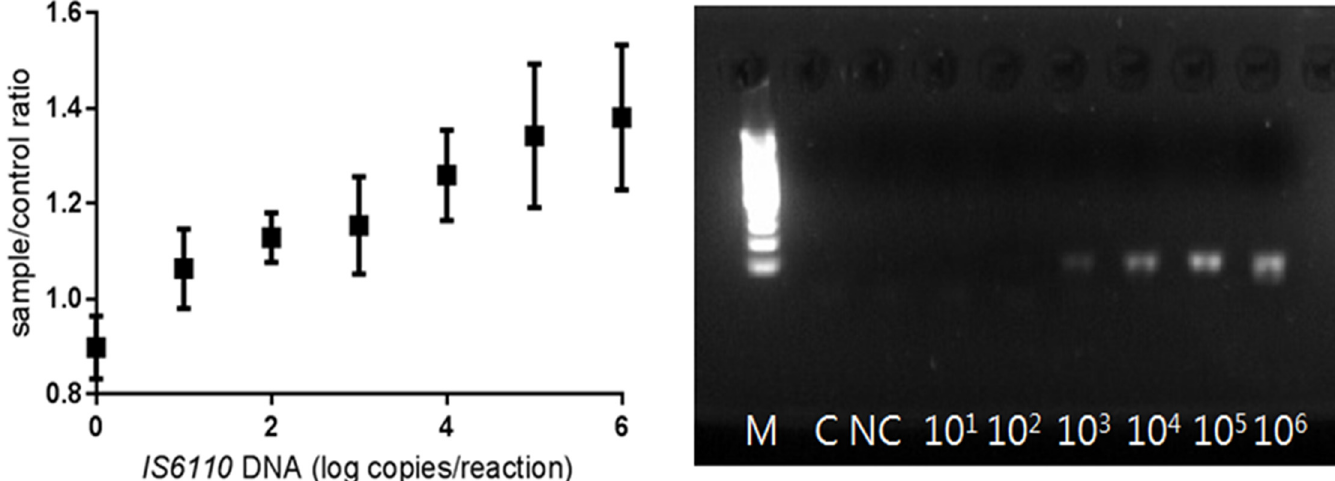
Fig 3. Detection sensitivity of the PCR-GO system. Left, The RFU ratios (sample/control) increased in proportion to the concentration of p-IS 6110 used for PCR amplification (10 1 – 10 6 copies/reaction). Negative group (no template control) was significantly different from positive groups (10 1 , 10 2 , 10 3 , 10 4 , 10 5 , 10 6 copies/reaction) (Tukey-Kramer multiple-comparison test, p < 0.05). 10 replicates were performed at each concentration. Right, Gel electrophoresis of the 113-bp amplicons after PCR amplification using 10 1 – 10 6 copies of the p-IS 6110 plasmid per reaction, as indicated. Right, C, blank; NC, no-template